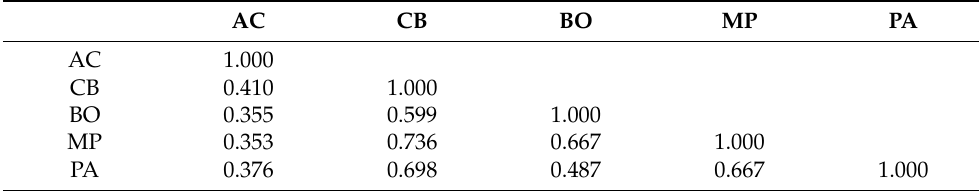
Table 8. Correlation statistic (Cram é r’s